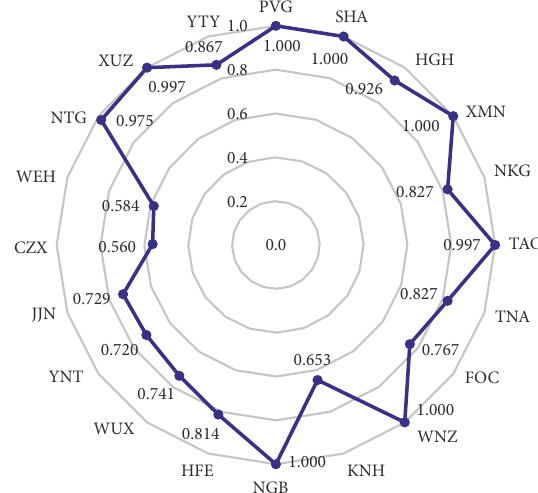
Figure 1. Average TEs of five years of 20 airports